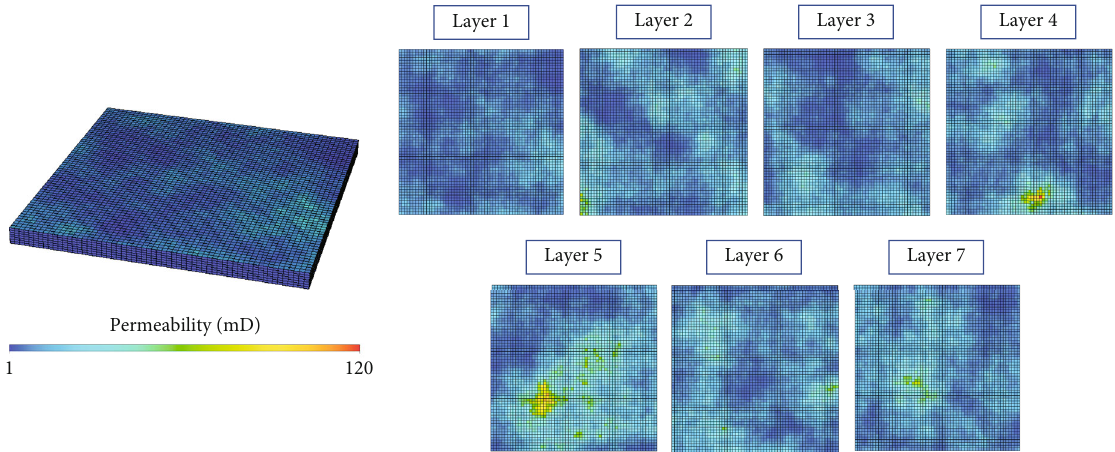
Figure 21: Permeability distribution of di ff erent layers for egg model.